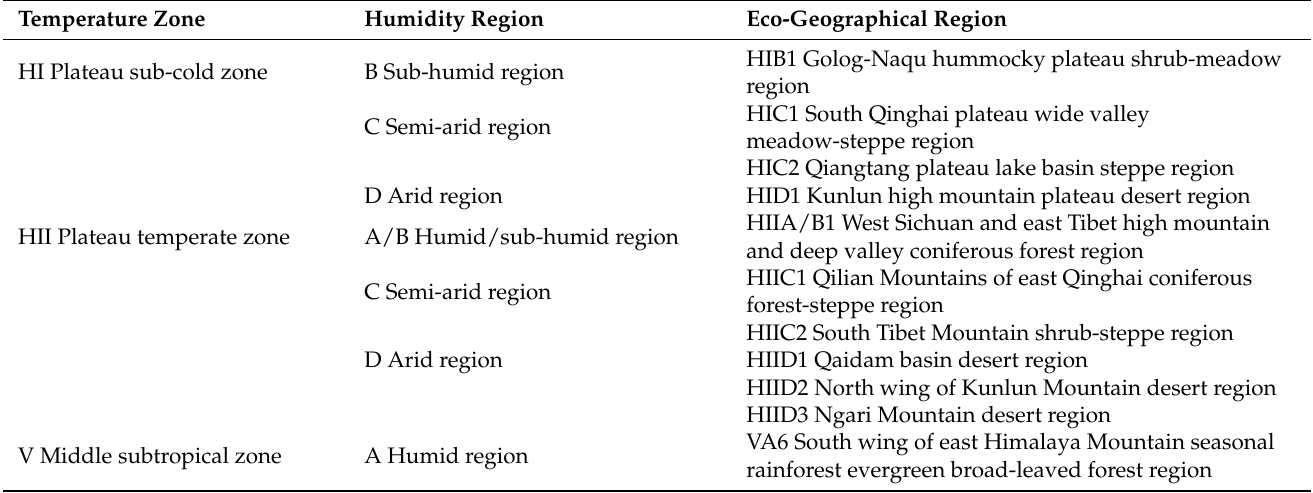
Table A1. Eco-geographical regions of the TP